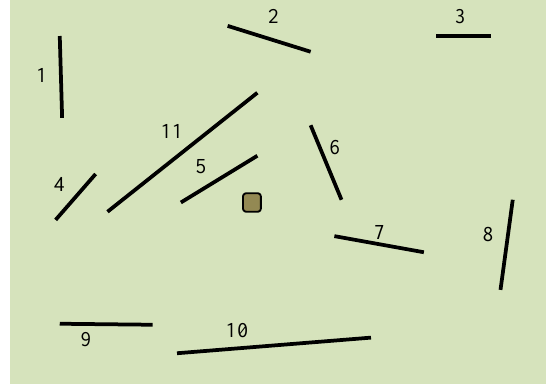
Figure 6. The experimental data contain 11 lines and one